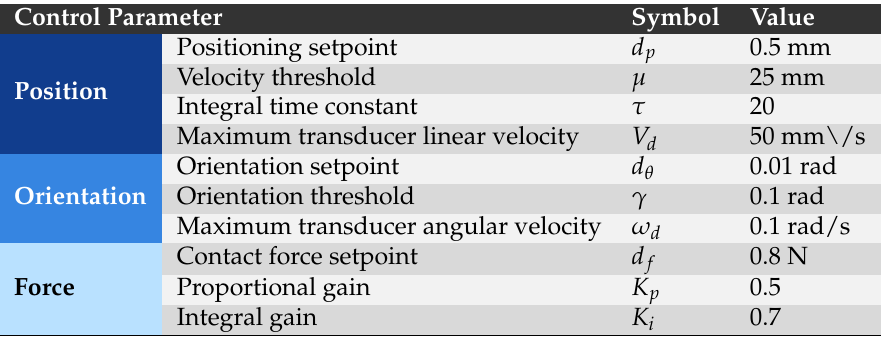
Table 1. The position, orientation, and force control parameters for the robotically-actuated ultra- sound (US) transducer. Each parameter can be referred to in Appendixes A and